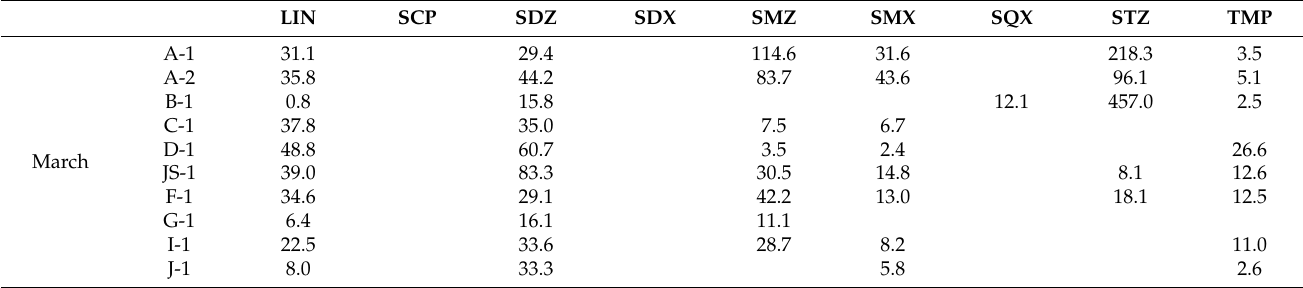
Table A3. Residual concentrations of antibiotics in the surface water samples (ng·L⁻ 1 ). Blank cells indicate samples where no antibiotic could be detected.